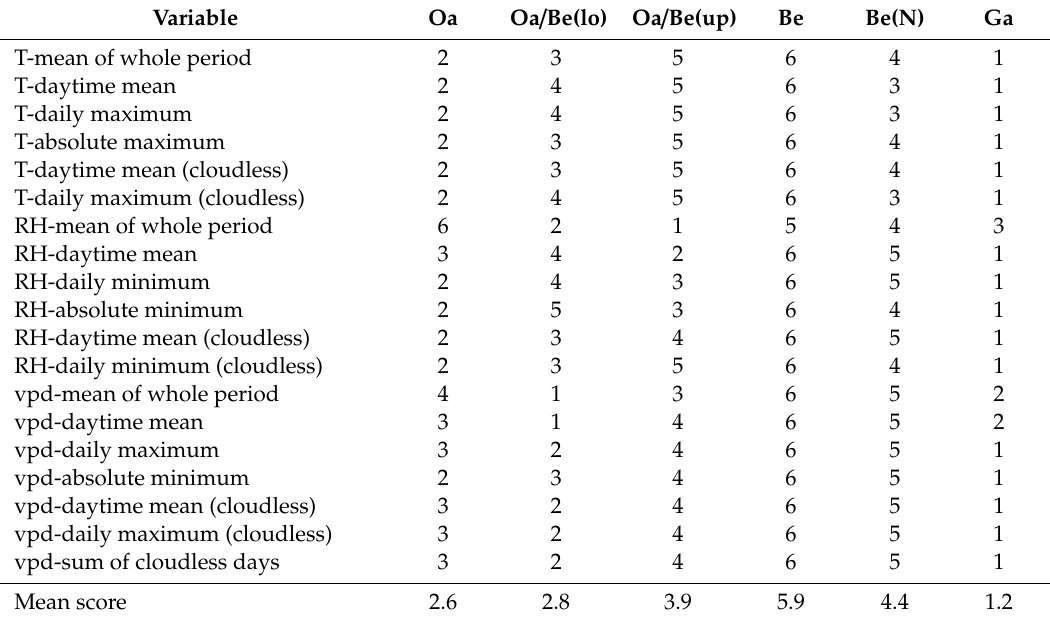
Table 6. Ranking of the five forest types and the gap according to microclimatic means and extremes recorded. In total, 19 di ff erent variables related to air temperature means and maxima, RH means and minima, and vpd means and maxima were expressed for the six measuring points with scores from 1 to 6 (1 = hottest and driest, 6 = coolest and moistest) and a mean score calculated by averaging over the 19 scores. Oa Oa / Be(lo) Oa /